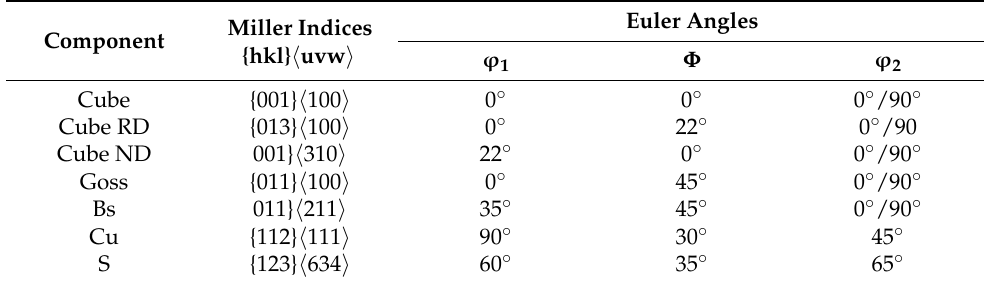
Table 6. Euler angles of ideal texture components